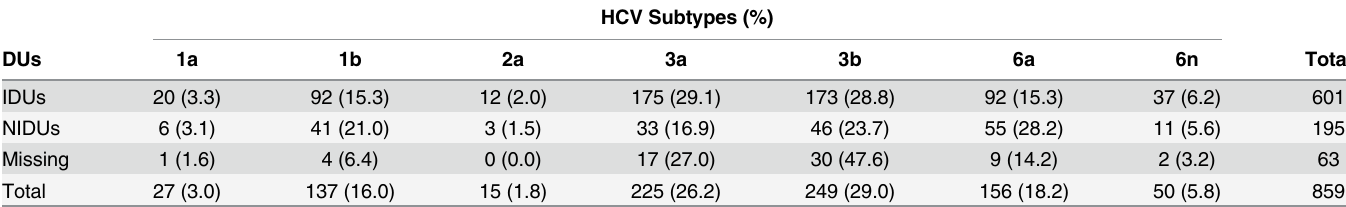
Table 2. HCV subtype distribution between intravenous drug users (IDUs) and non-injection drug users (NIDUs) in China.